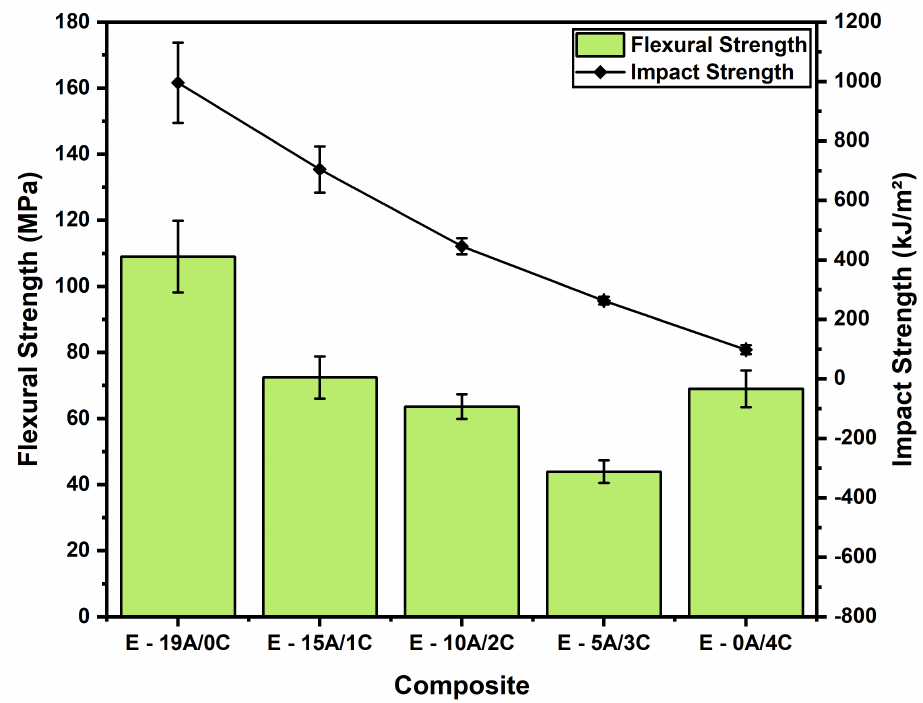
Figure 4. Comparison of flexural and impact strength results of hybrid laminated